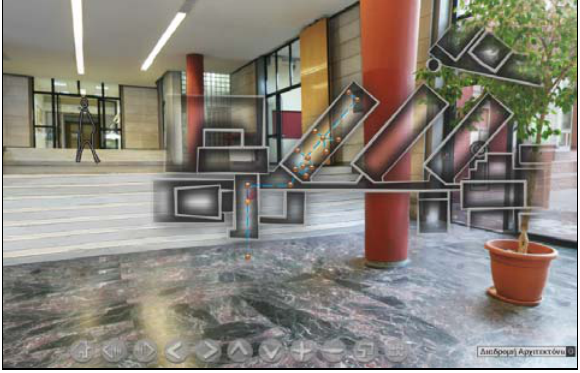
Figure 15. The man’s figure in the next panorama position.